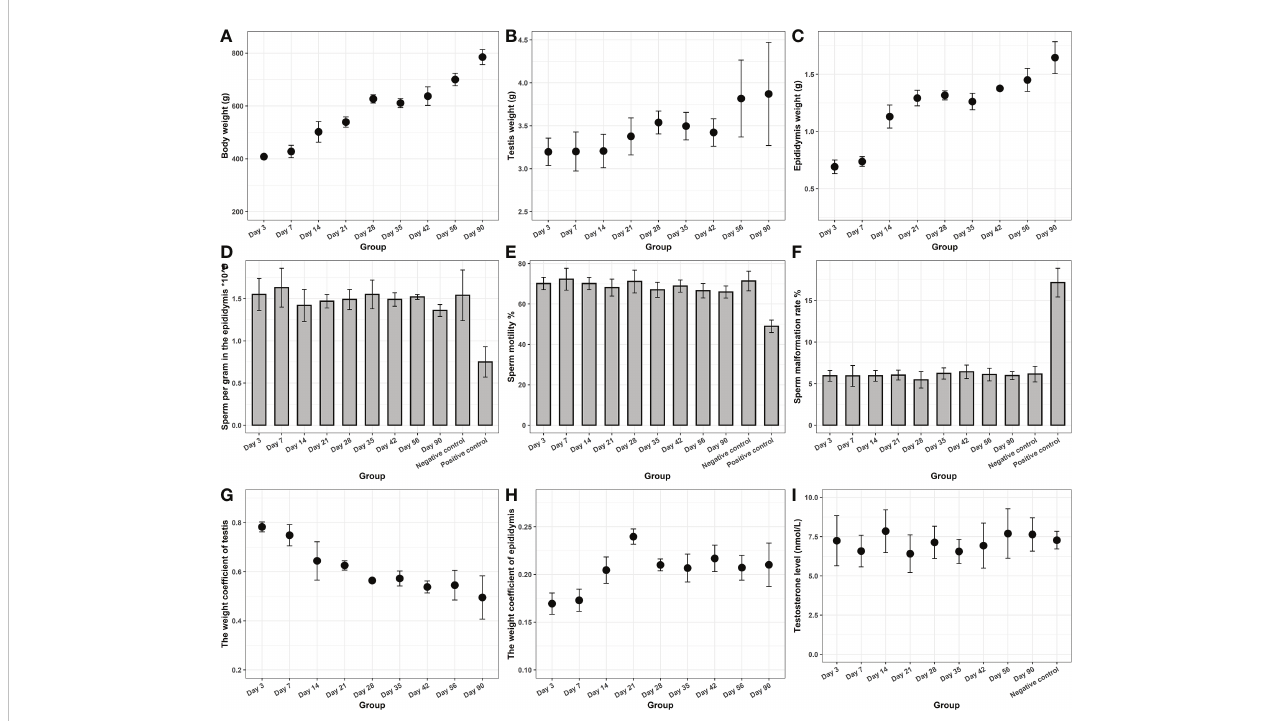
FIGURE 4 Reproductive toxicity of the novel hydrogel. The body weight (A) , epididymis (B) , and testis weight (C) of rats. (D) The epididymal sperm count. (E) The sperm motility. (F) The sperm malformation rate. (G) The weight coef fi cient of the testis. (H) The weight coef fi cient of the epididymis. (I) Testosterone